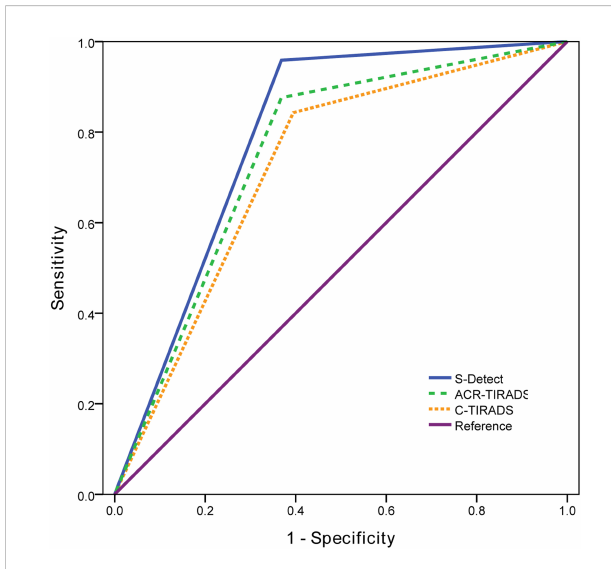
FIGURE 3 The receiver operating characteristic (ROC) curves of S-Detect and two TI-RADS classi fi cations.